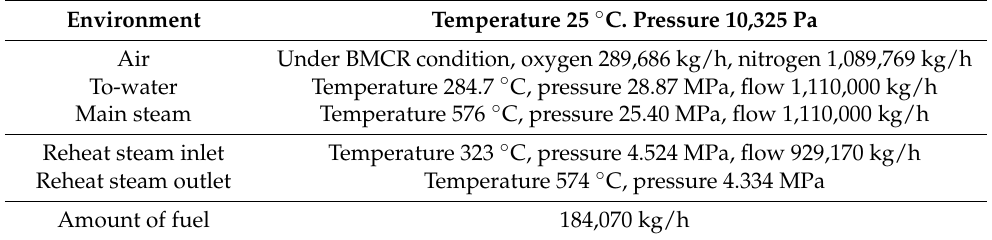
Table 11. Model parameters of improved scheme.